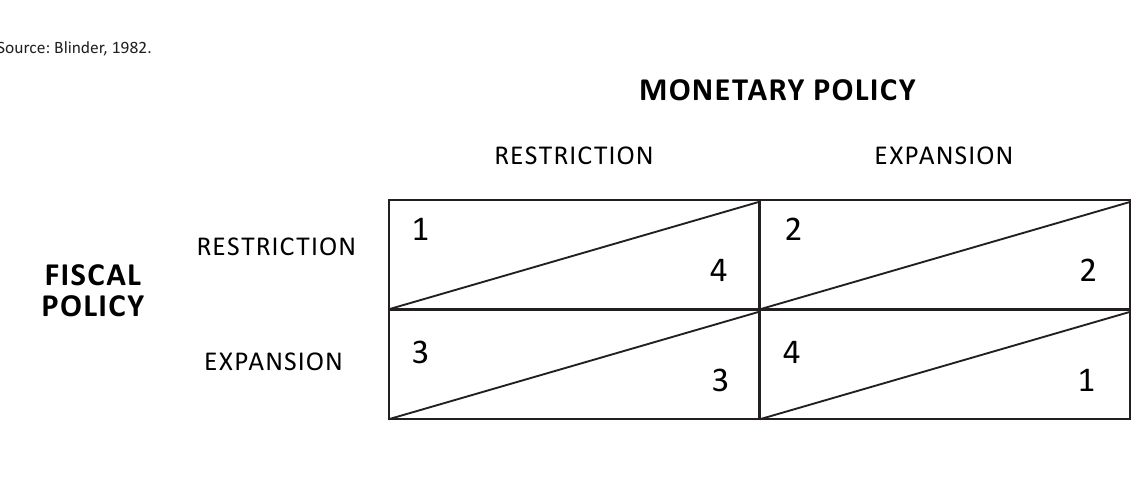
Figure 4. The matrix of interaction between government and central bank Note: evaluation of events by central bank appeared above the diagonal in each box, and evaluation of events by government appeared below the diagonal in each box.